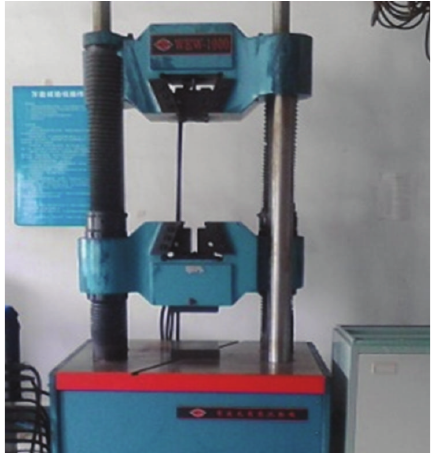
Figure 2: Compression testing machine 2